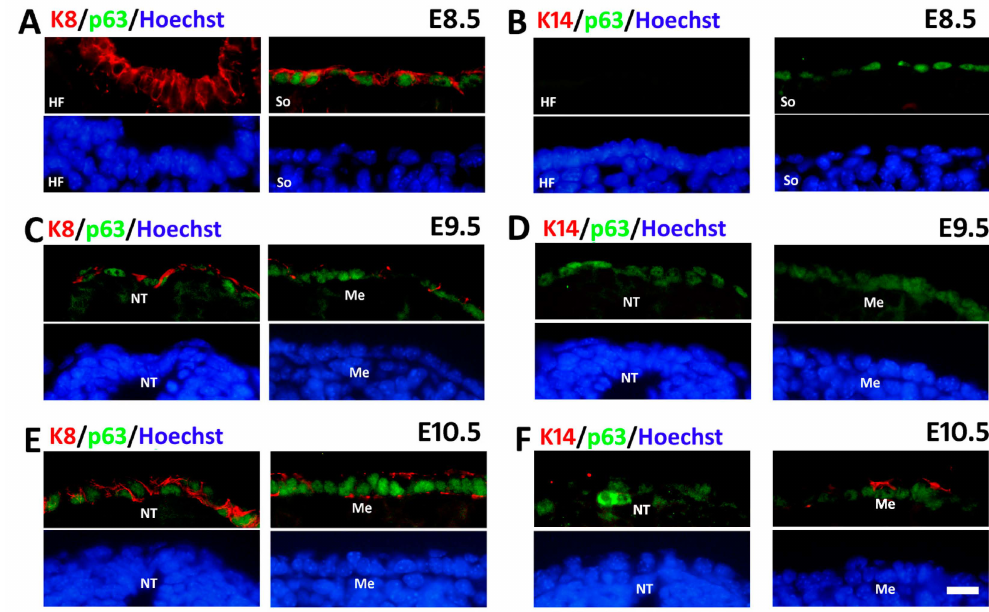
Figure 5. Double immunofluorescence staining of p63 with K8 and K14, respectively. ( A , C , E ) Immunofluorescense analysis of K8 (red) and p63 (green) during mouse skin development at E8.5–E10.5 ( B , D , F ) Immunofluorescense analysis of p63 (green) and K14 (red), during mouse skin development at E8.5–E10.5 Hoechst33342 was used to indicate the nuclei. HF, head field; So, somite; NT, neural tube; Me, mesenchyme. Bar = 20 µ